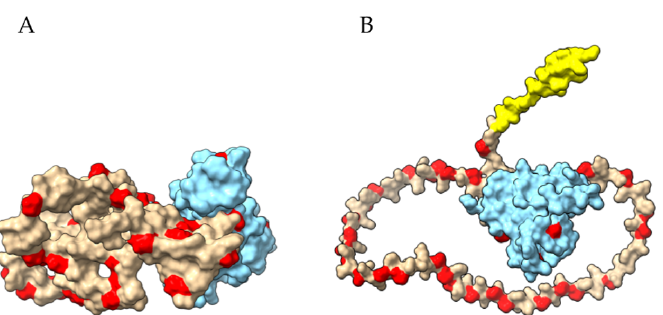
Figure 11. ( A ). Localization of cleavage sites for prolyl endoprotease (red spots) exposed on the molecular surface of the N ‐ disordered (colored tan) and C ‐ ordered (colored light blue) domains of the three ‐ dimensional model built for the γ 5 ‐ gliadin. ( B ). Localization of cleavage sites for prolyl endoprotease (red spots) exposed on the molecular surface of the N -disordered (colored tan) and C -ordered (colored light blue) three-dimensional model built by AlphaFold for g3-gliadin. The signal peptide is colored yellow.